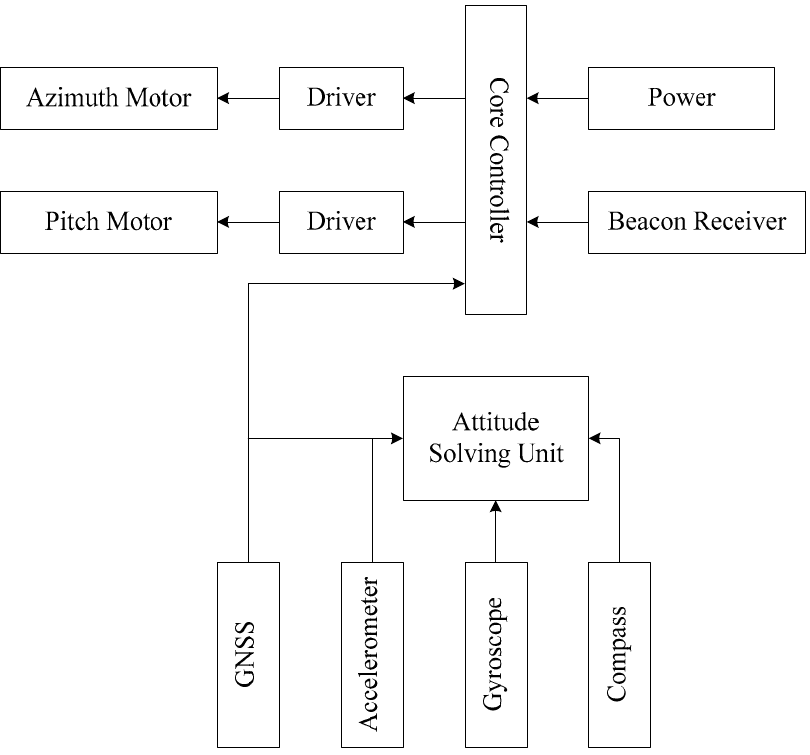
Figure 2. Structure of SOTM Servo Control System.